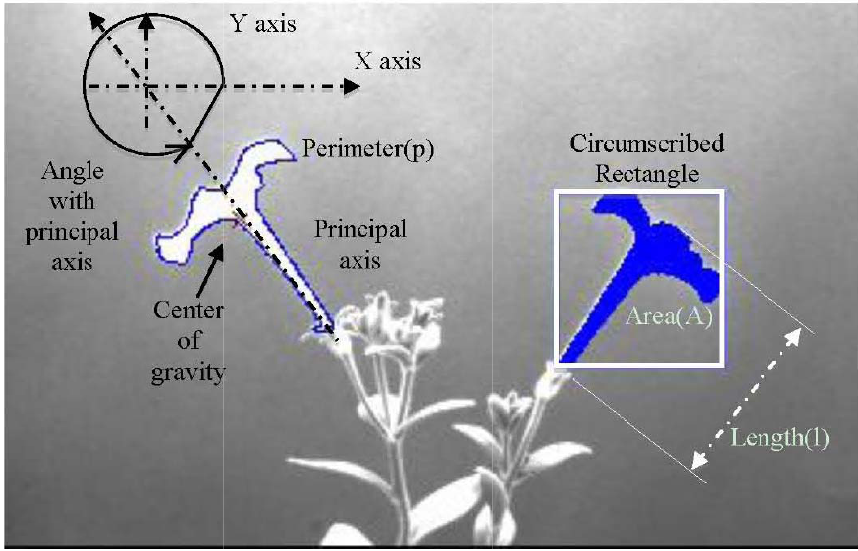
e 8. Calcula Petuni ia